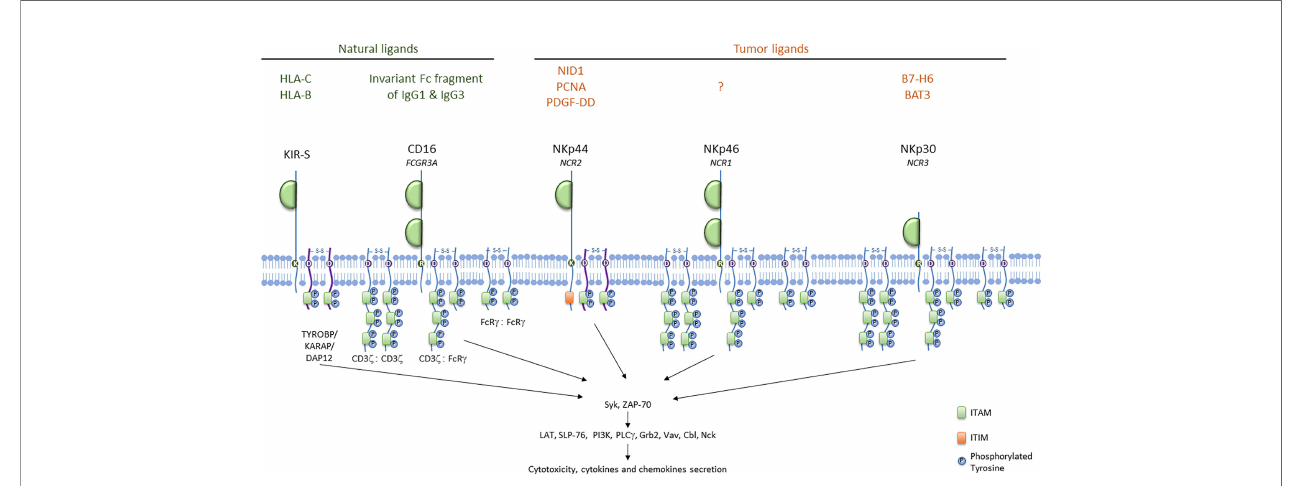
FIGURE 1 | ITAM-bearing receptors in humans. ITAM-bearing receptors in humans are represented at the membrane associated either with CD3 z or with FcR g as homo- or heterodimers. ITAM motifs are represented with the proteins involved in the activation signal cascade. Natural ligands for KIR-S and CD16, and tumor ligands for NCRs are